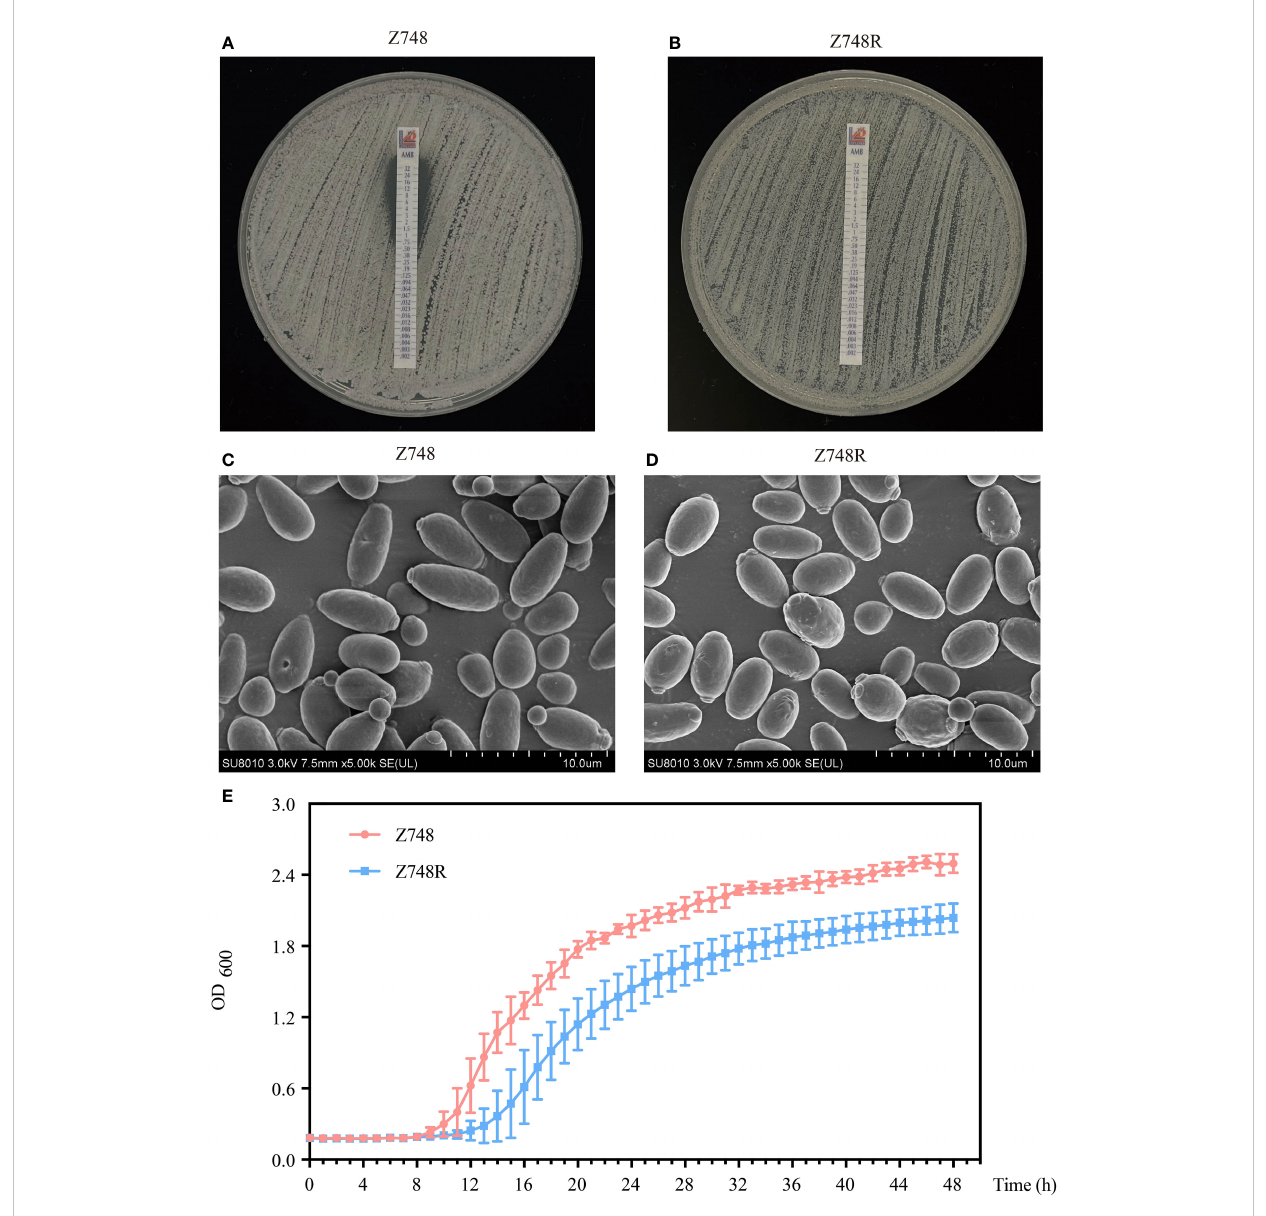
FIGURE 1 Phenotypic changes between AMB-sensitive C . krusei (Z748) and the AMB-resistant strain (Z748R). (A, B) MIC values of Z748 (A) , Z748R (B) . (C, D) Morphological characteristics of Z748 (C) and Z748R (D) under a scanning electron microscope. (E) 48-h growth curve of Z748 and